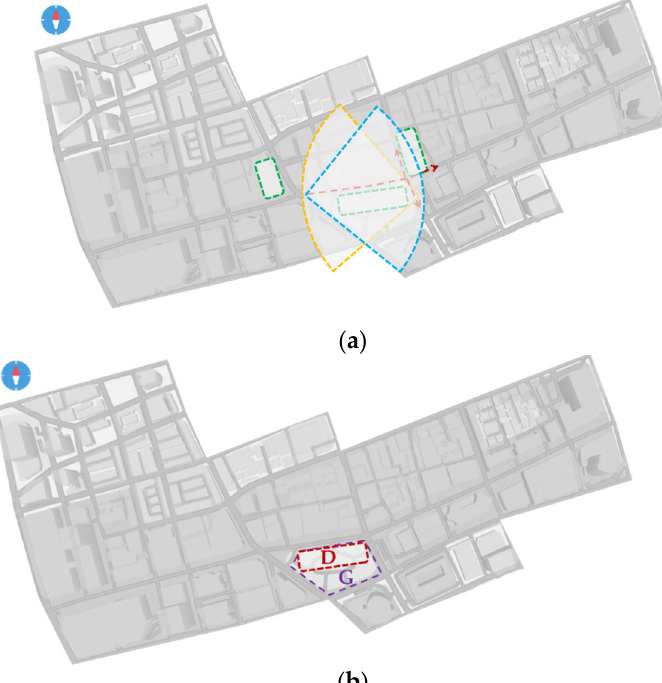
Figure 12. Positioning results of all compound spatial assertions. ( a ) shows all candidate location in Figure 11. ( b ) is the overlap of all candidate location. Besides, D is the location of Century Square determined by the candidate location, and G is the real location of Century Square.